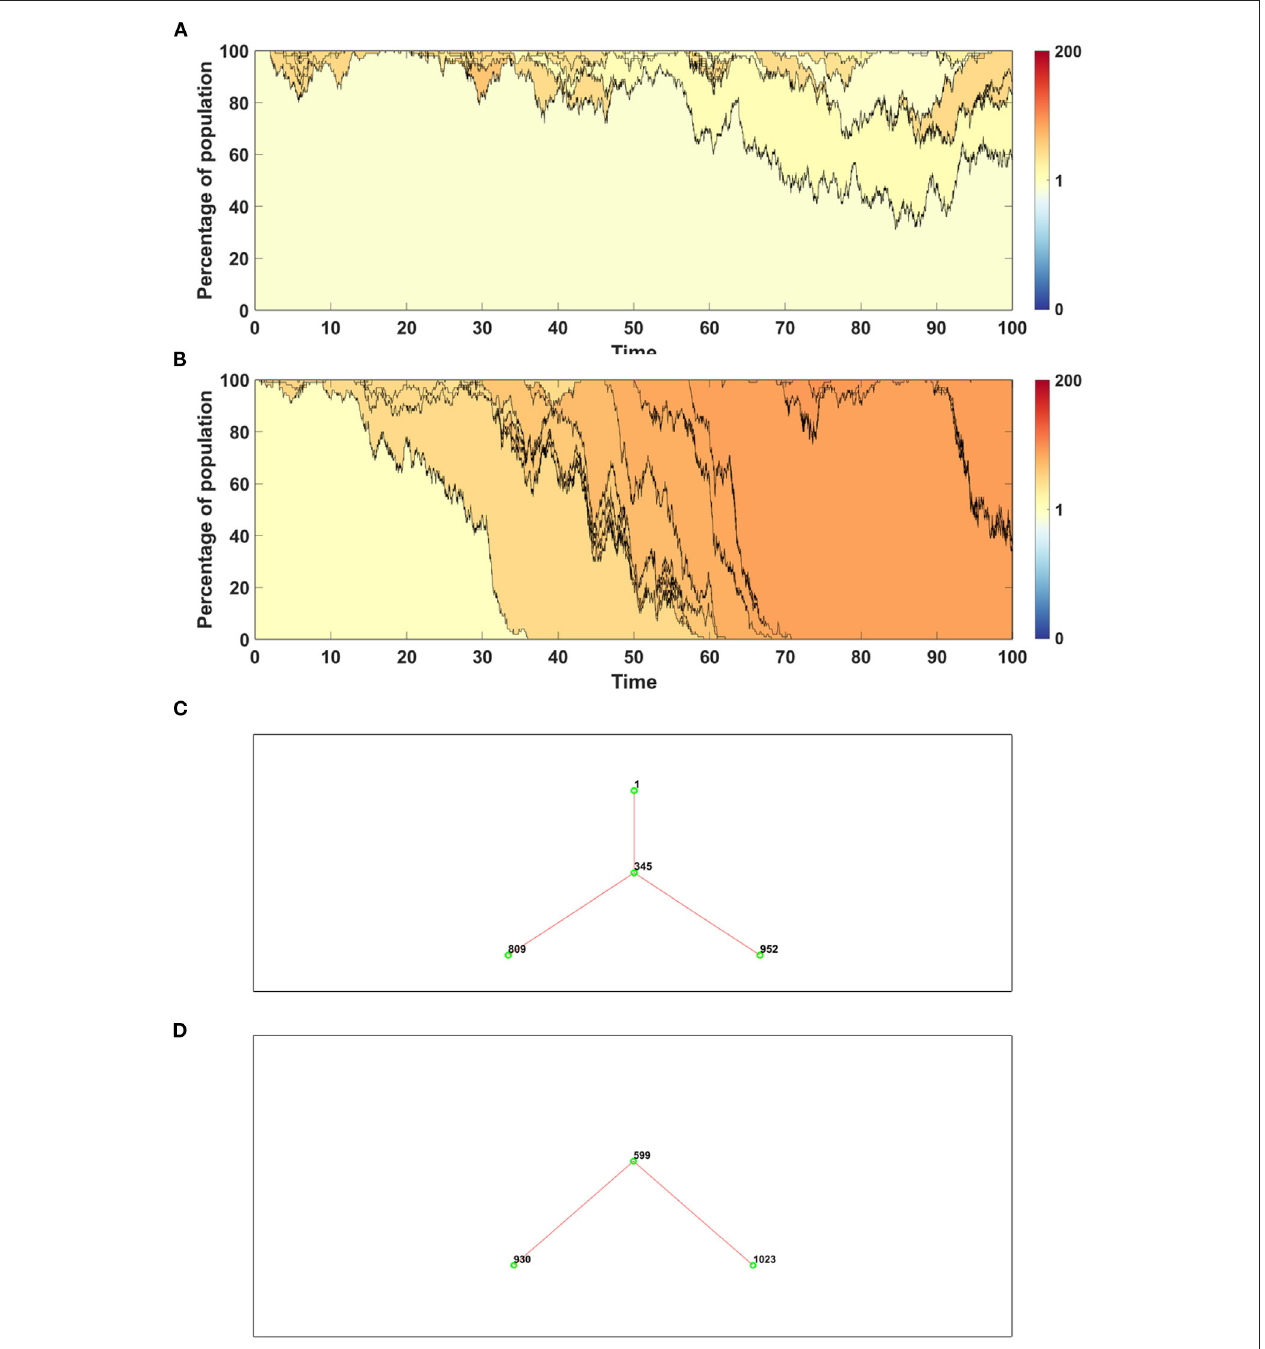
FIGURE 9 | Time succession patterns. Clones started with driver mutations are colored according to average fitness of given clone. Results of one simulation on N = 100 cells with parameters: s = 0.1, d = 0.01, µ = 0.1, p = 0.0909. (A) Model A; (B) Model B. Genealogy of clones. Results of one simulation on N = 100 cells with parameters: s = 0.1, d = 0.01, µ = 0.1, p = 0.0909. (C) Model A–genealogy of clones started from driver mutation, alive at t = 100 (out of 992 clones emerged through the time of simulation). (D) Model B–genealogy of clones started from driver mutation, alive at t = 100 (out of 1041 clones emerged through the time of simulation).